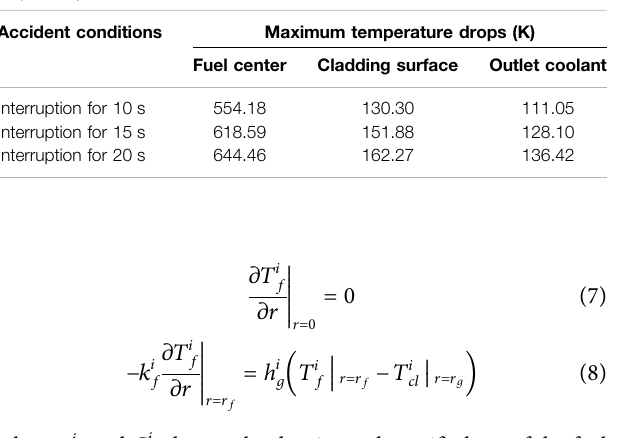
TABLE 3 | Temperature variations of the fuel center, cladding surface and outlet coolant in the hottest channel under beam interruptions for 10 s, 15 s, 20 s